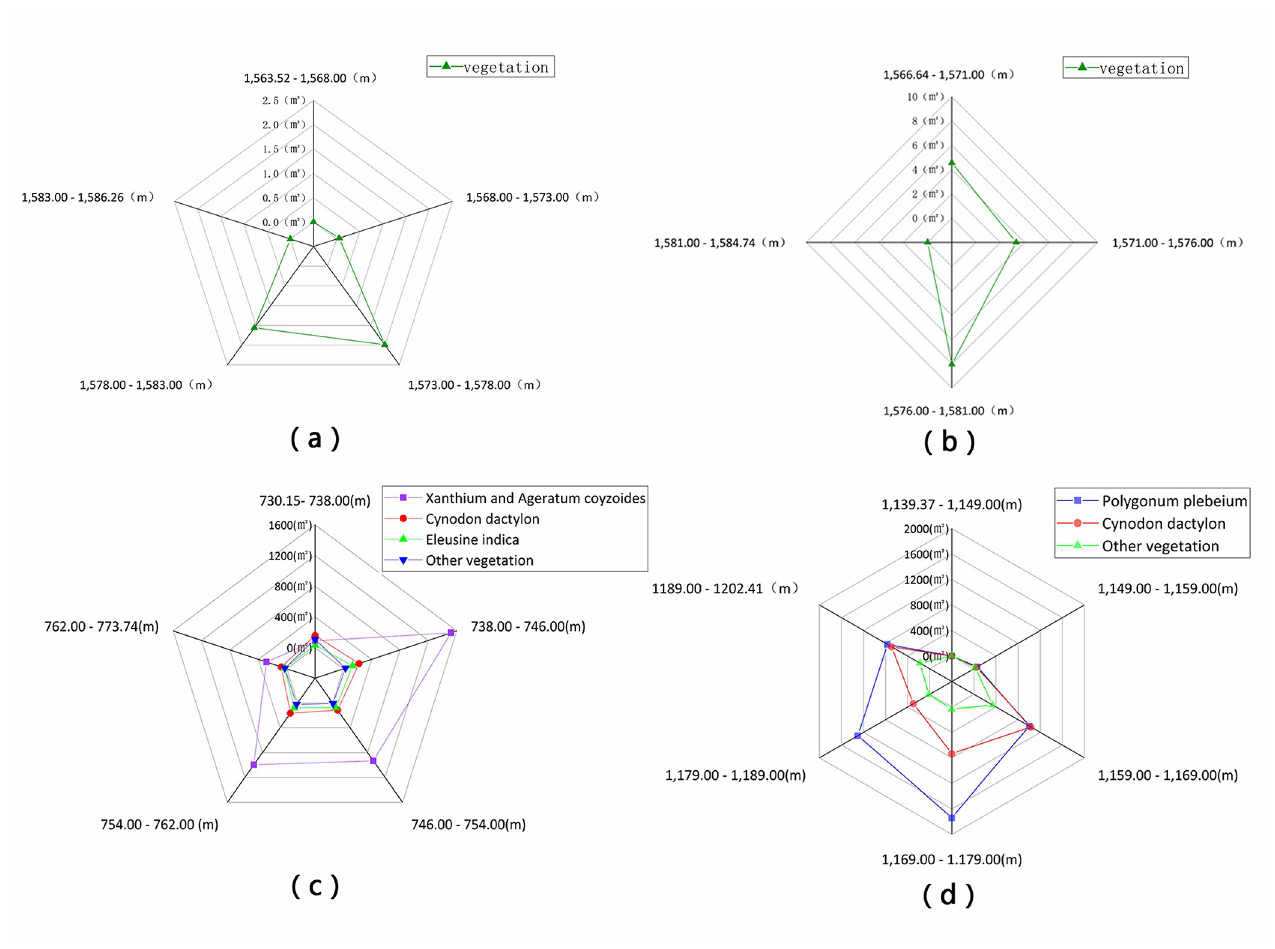
Fig 7. Vegetation distribution area as a function of elevation in the WLFZ of (a) Huangdeng study area 1, (b) Huangdeng study area 2, the (c) Nuozhadu study area, and the (d) Xiaowan study area.